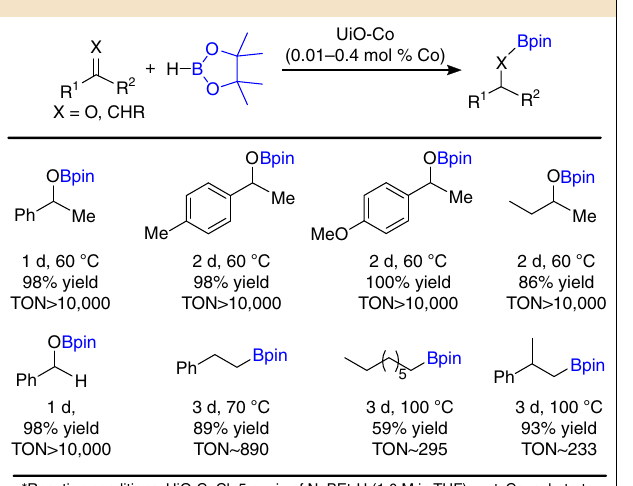
Yields were determined by 1 H NMR using MeNO 2 as internal standard. Isolated yield in the